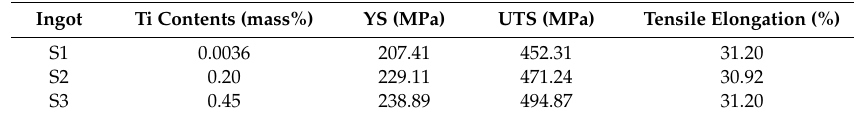
Table 2. Tensile properties of ingots with different Ti content at 350 °C. YS, yield strength; UTS, ultimate tensile strength.